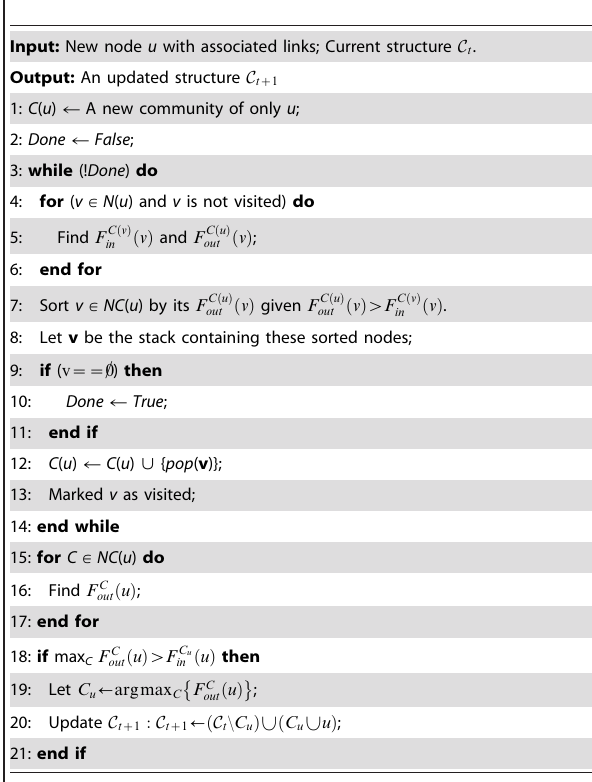
Table 1. Algorithm 1.